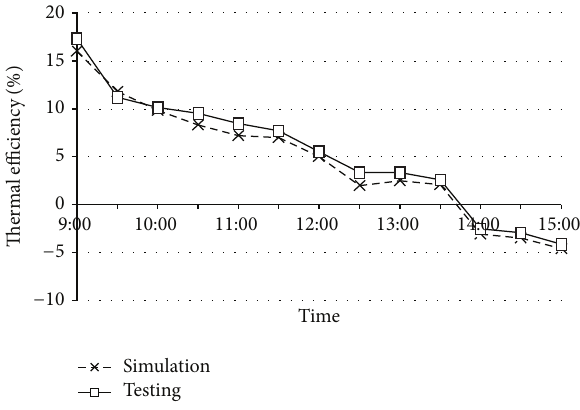
Figure 4: Variation of thermal efficiency in the daytime. is the temperature of “ 𝑤 ” (𝑇 𝑤 = (𝑇 𝑜 + 𝑇 𝑇 are the temperatures of outlet and inlet of the manifold). in